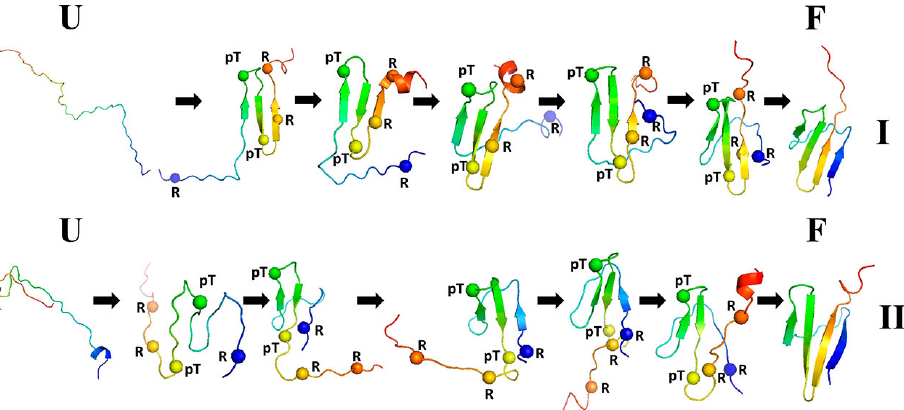
Figure 6. Two folding pathways of pT37pT46 4E-BP2 18 − 62 found by UNRES MD simulations. Reproduced with permission from A.K. Sieradzan et al., J. Chem. Theory Comput. 17, 3203–3220 (2021). Copyright 2021 American Chemical